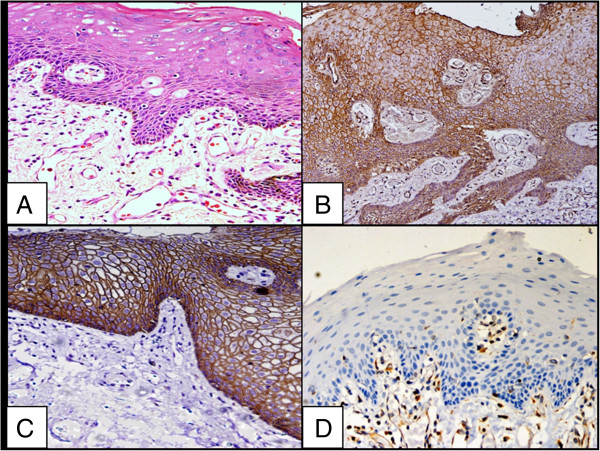
Staining pattern of normal buccal mucosa. A. Normal buccal mucosa, H&E X200; B. High immunoreactivity of β-catenin in normal buccal mucosa X200; C. High immunoreactivity of E-cadherin in normal buccal mucosa X200; D. Absence of immunostaining for vimentin in normal squamous epithelium of buccal mucosa X200.